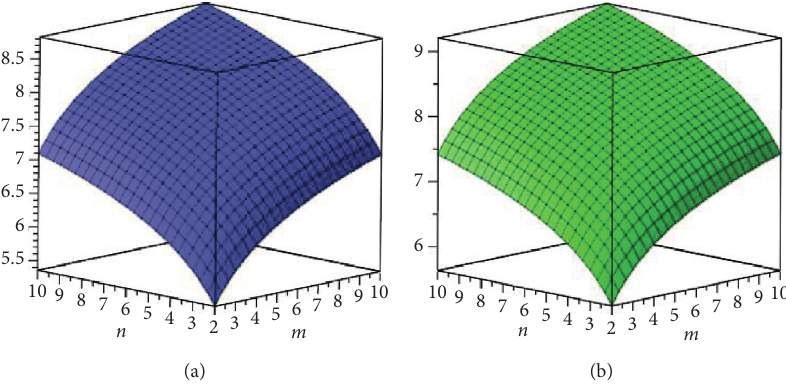
Figure 16: (a) The first Zagreb entropy; (b) the second Zagreb entropy.